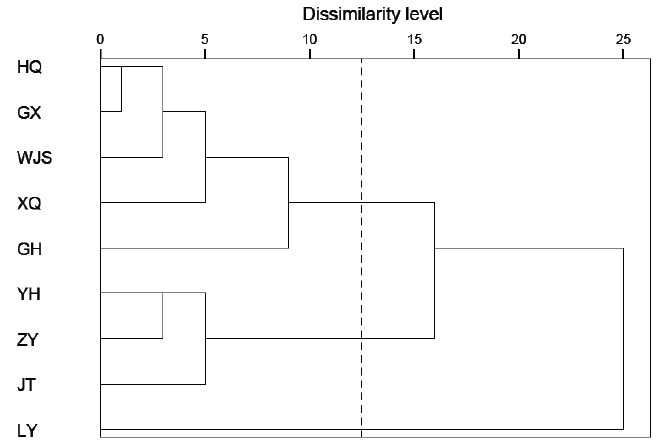
Figure 7. Dendrogram of different clusters of air quality monitoring stations ( y -axis reports the level of dissimilarity, while the dotted line is the clustering level).